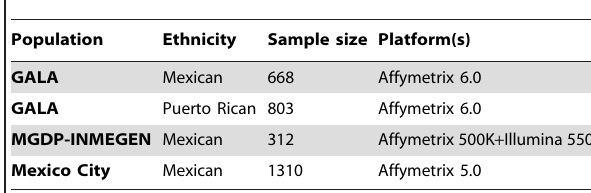
Table 6. Samples used for validation.